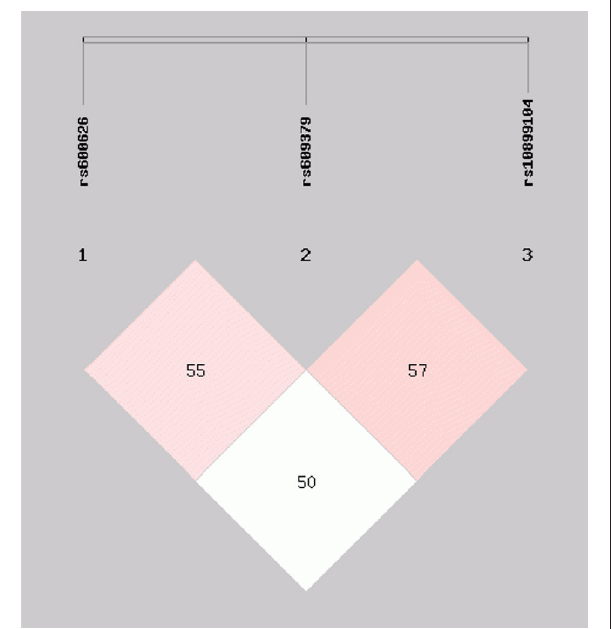
FIGURE 1 | Linkage disequilibrium (LD) analysis within MOGAT2 region (SNPs in LD) in control and IS groups. D’ > 0.5.